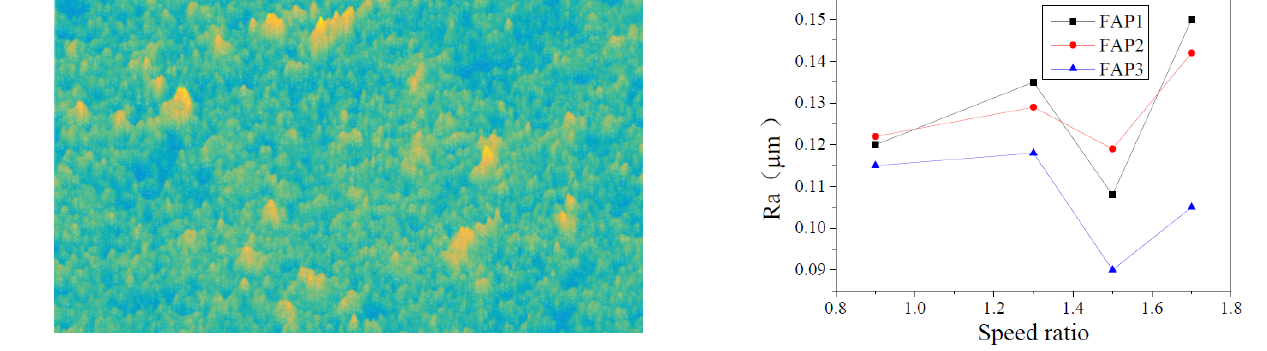
Figure 12. Workpiece morphology extraction processed by FAP1.